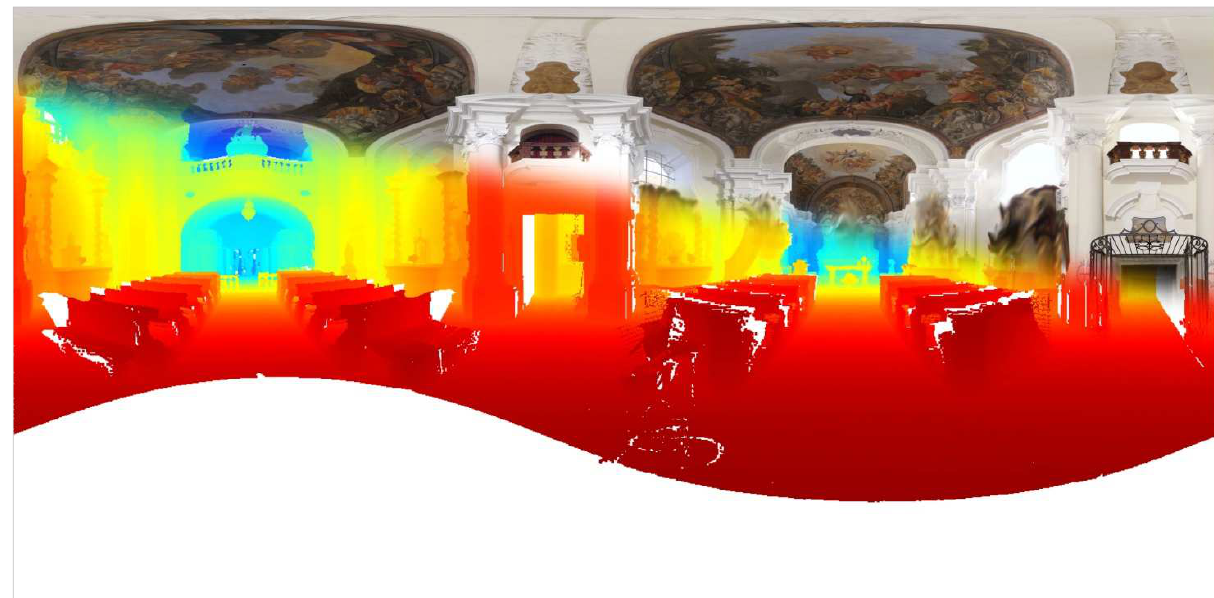
Figure 8. Fused image. The transformed range image has been overlaid over the panoramic image and diagonally cropped in order to visually show the correctness of the estimation of transformation parameters.